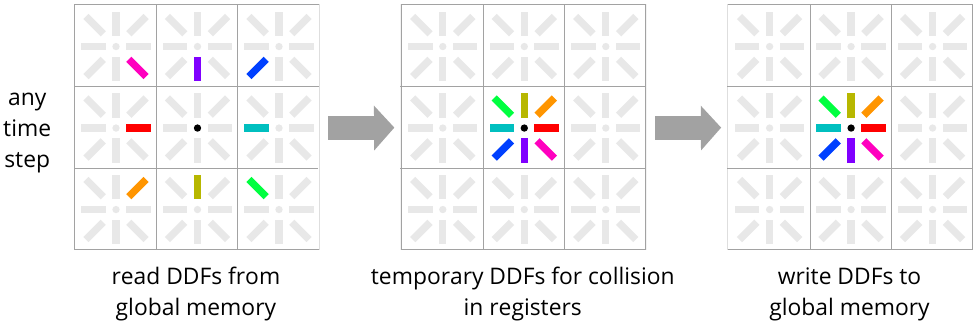
Figure 1. One-Step-Pull streaming scheme. Two copies of the DDFs are used to resolve data